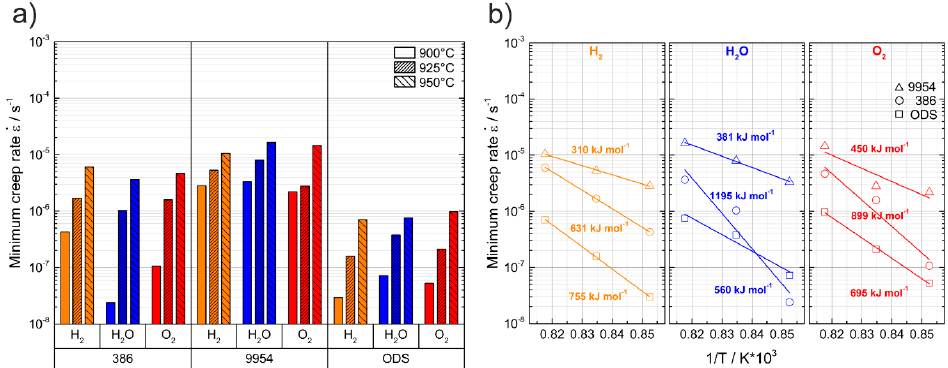
Figure 5. Minima creep rates ( a ) and activation energies ( b ) of testing temperatures of 900–950 °C. The samples of Amdry 386, Amdry 9954 and Amdry 9954 + ODS were heat treated before creep testing in Argon with the additions of 4% H 2 + 2% H 2 O, 2% H 2 O and 20% O 2 .